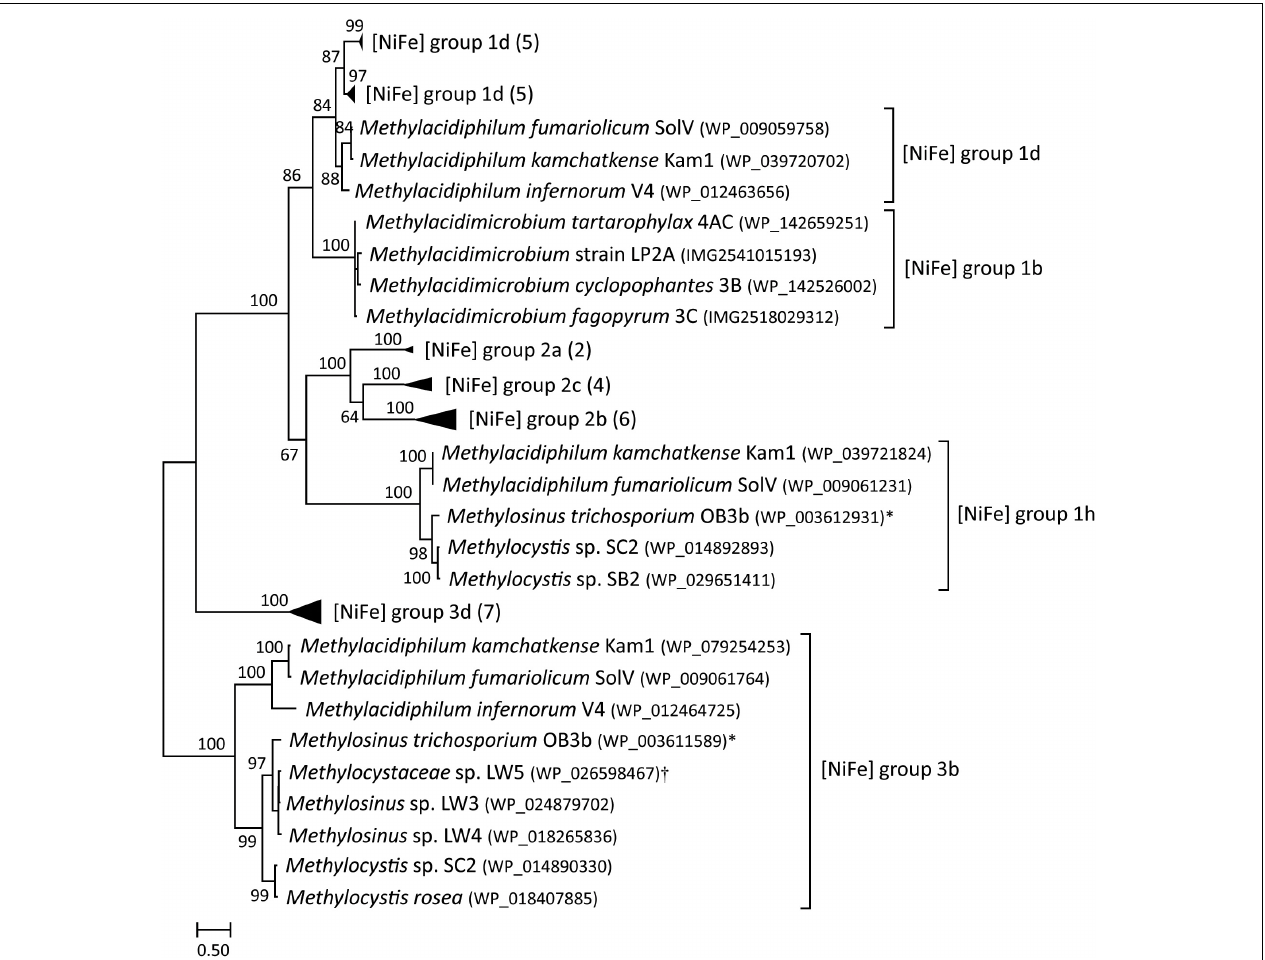
FIGURE 2 | A maximum-likelihood phylogenetic tree based on the protein sequences of [NiFe] hydrogenases (large subunit) found in methanotrophs. Hydrogenase group labels are based on HydDB. The number of sequences in collapsed branches is shown in parentheses. Bootstrap scores are based on 500 replicates. ∗ Multispecies record that also includes Methylosinus sp. 3S-1; † Multispecies record that also includes Methylocystis sp.